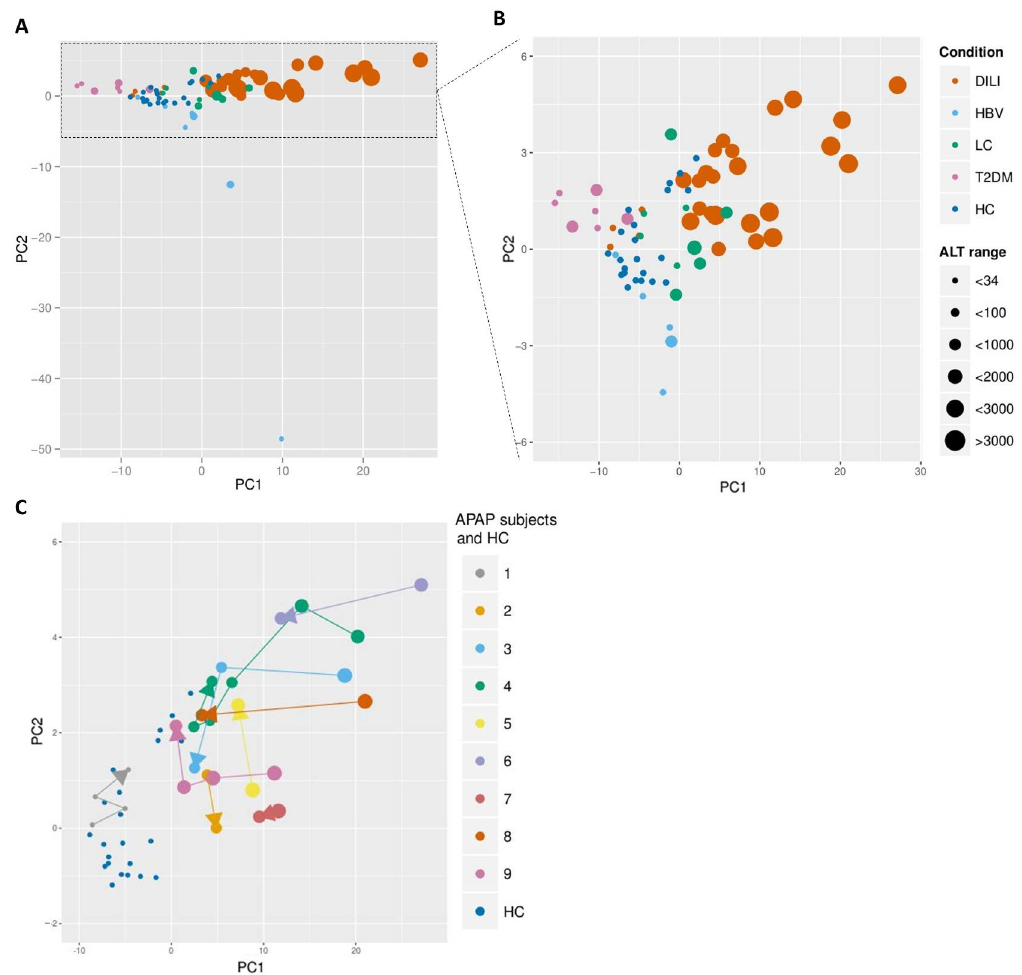
Fig 1. Unsupervised principal component analysis. The PCA presents the serum miRNA and simultaneously the observedALT levels per subject/sample. The analysisrevealedfour distinct clusters with subjects/samples clustering accordingto their respectiveliver impairment or T2DM (A) (B). Samples, taken at varioustime points between1 and 7 days after APAP overdose,show a tendencyof clustering towards the control group, which suggests a recovery from liver impairment. Different subjects have varying numbers of time points (ranging2–6). The temporal sequenceof samples is indicatedby arrows (C). ALT levels alone were not capableof discriminating patient groups (A) (B) or identifying recovery after APAP overdoses